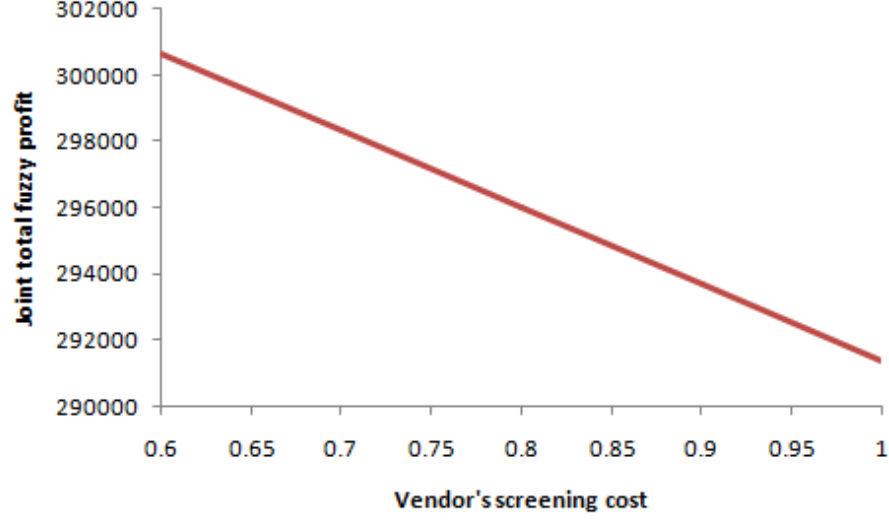
Figure 19. Vendor’s screening cost vs. the joint total fuzzy profit.